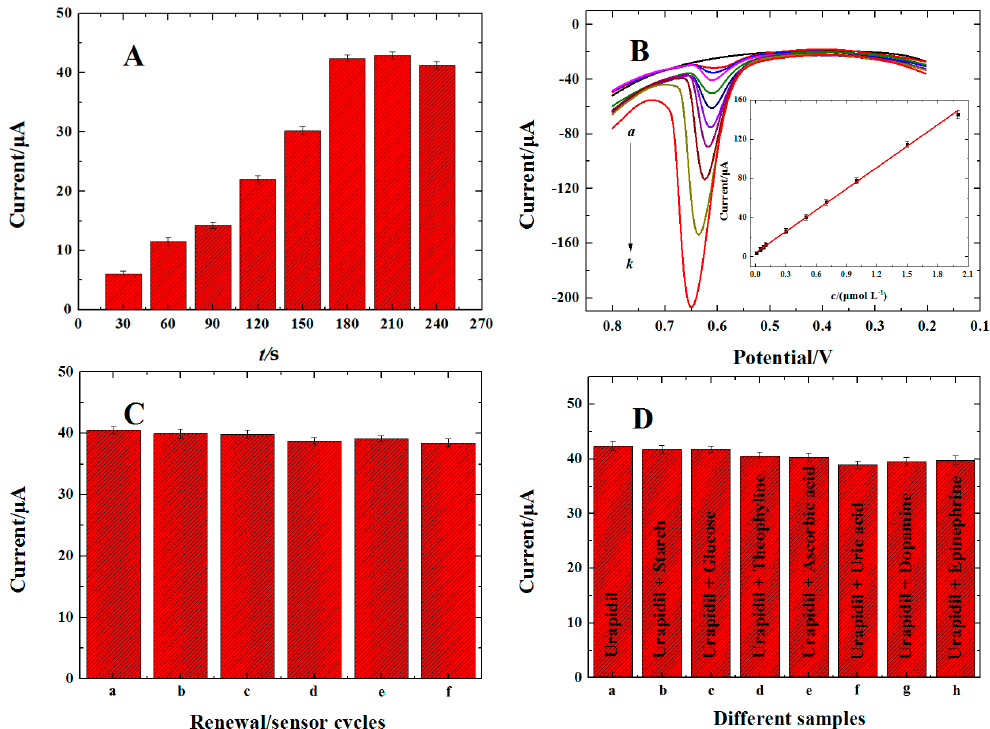
Figure 8. ( A ) Peak current vs. accumulation time plots for 5.0 × 10 − 7 mol·L − 1 urapidil at open circuit condition; ( B ) DPASVs of different concentration of urapidil on 3DG-NCNTs modified GC electrode under the optimum conditions; the inset shows corresponding calibration curve of c for i pa ; ( C ) Influence of renewal step on the i pa detected on 3DG-NCNTs modified GC electrode; ( D ) Influence of different interfering compounds on the i pa detected on 3DG-NCNTs modified GC electrode.